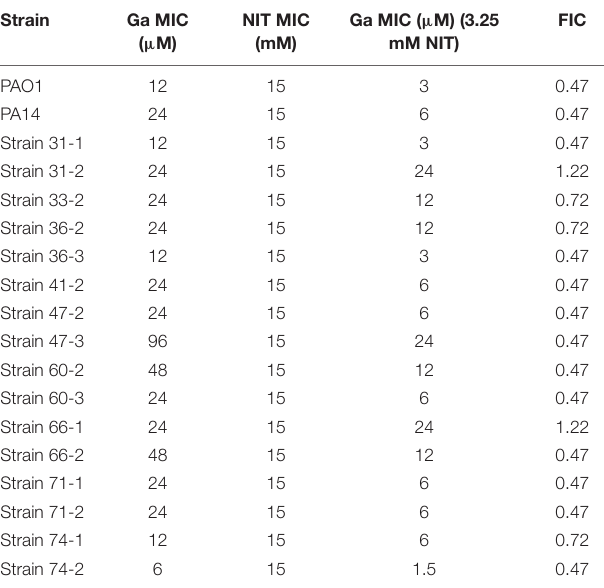
TABLE 1 | Checkerboard assay for nitrite-Ga(III) interaction for P. aeruginosa grown aerobically on M9 media with glucose as a carbon source. Strain